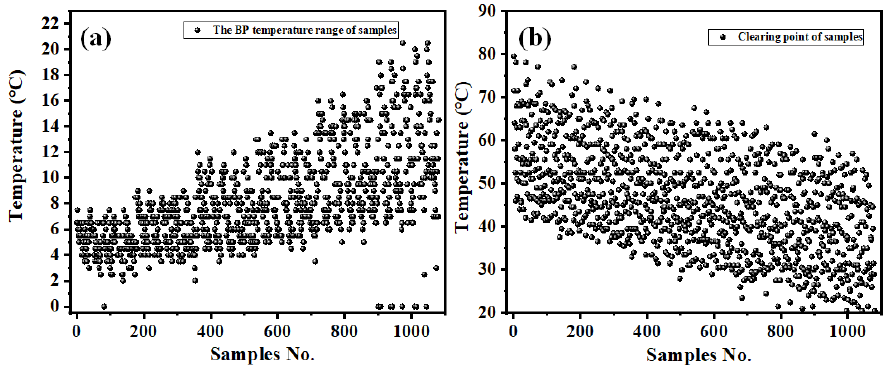
Figure 4. Scatter plot of ( a ) the blue-phase (including spherical phase) temperature range and ( b ) the clear points of 1080 LC samples.